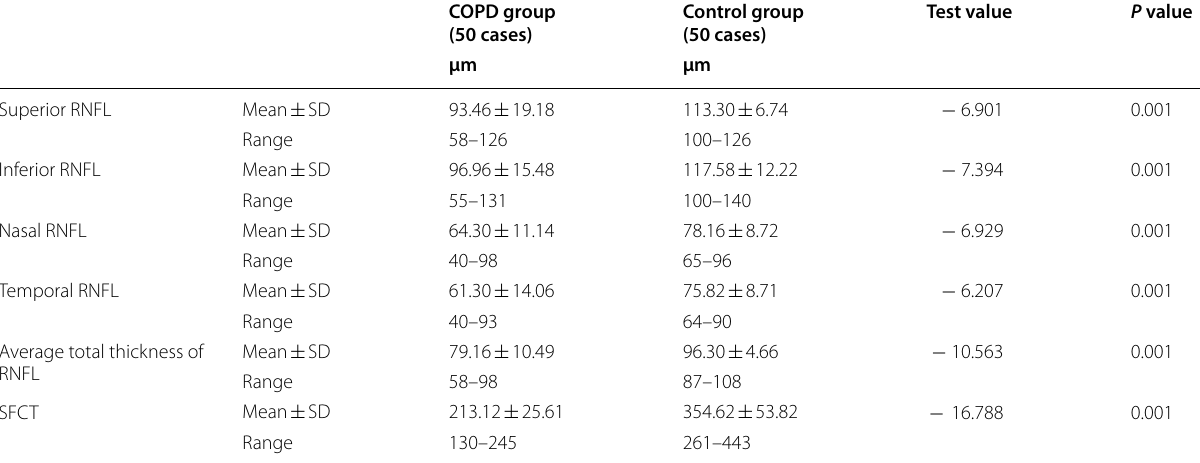
COPD chronic obstructive pulmonary diseases, FEV 1 forced expiratory volume in the first second, RNFL retinal nerve fiber layer, SFCT subfoveal choroidal